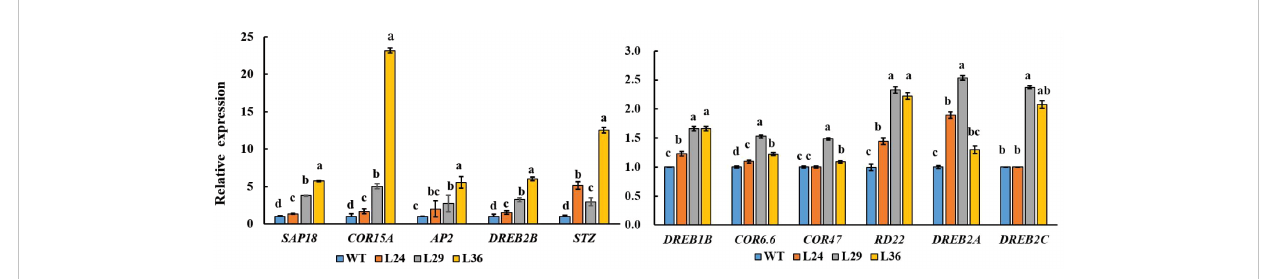
FIGURE 10 The expression of stress-related genes in WT and transgenic Arabidopsis lines overexpressing GhGT23 . Each bar represents the average of three experiments with 12 plants used in each experiment. The expression of stress-related genes in WT plant was set to 1 as control. Different letters indicate signi fi cant differences between the control plants and transgenic lines from the same gene which were determined using ANOVA, followed by Duncan ’ s multiple comparison test (p <